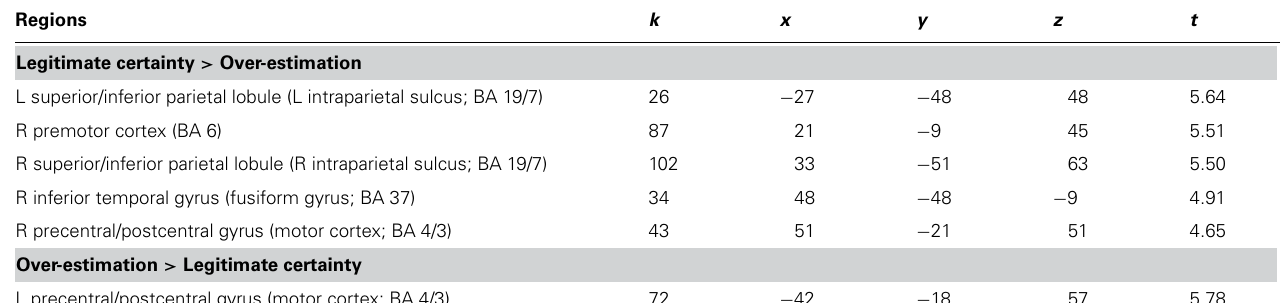
Table 3 | Overview of the neuroimaging results ( p < 0.0005, uncorrected, min. 20 voxels, MNI coordinates in mm, L = left, R = right, LR = left and right). Regions k x y z